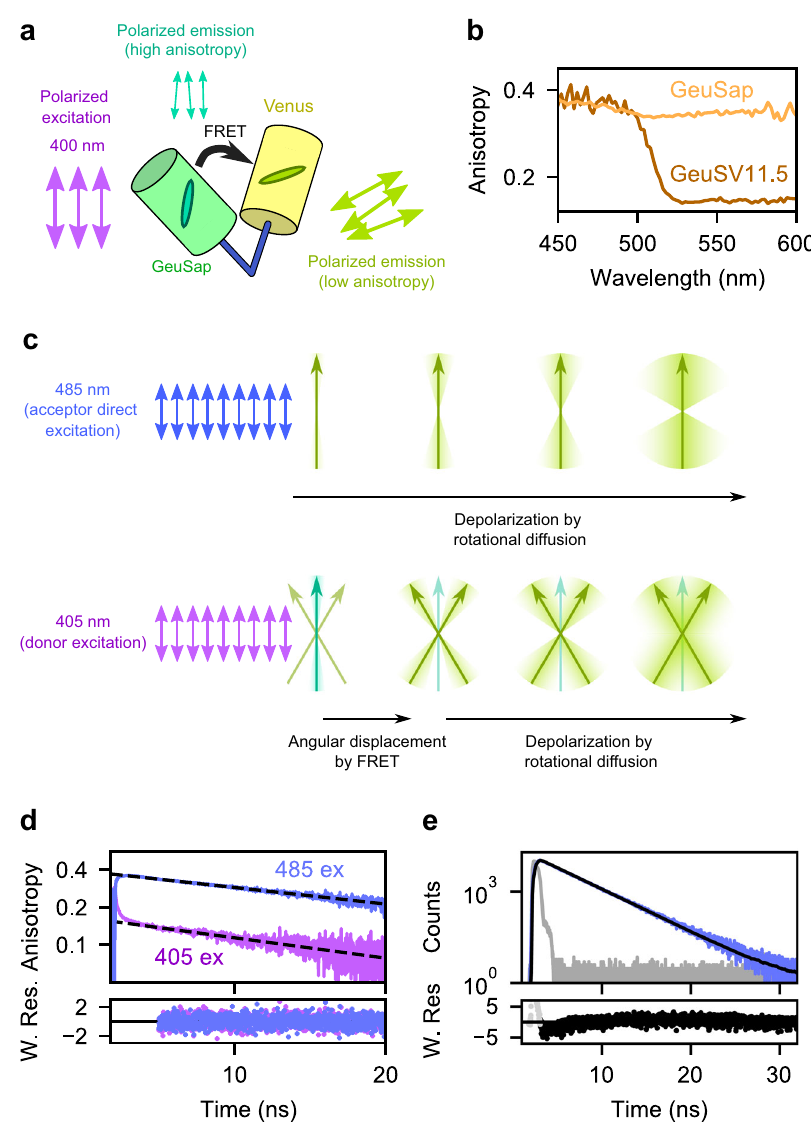
Fig. 3 GeuSV11.5 anisotropy. a Cartoon representation of GeuSV11.5 under polarized excitation. b Steady-state anisotropy spectra of GeuSap and GeuSV11.5. c Top: schematic drawing of direct acceptor excitation of GeuSV11.5 by linearly polarized light. The yellow-green arrow represents the emission dipole moment of the acceptor. After absorption of polarized light, the polarization of the emitted light is gradually lost as a result of rotational diffusion. Bottom: donor excitation of GeuSV11.5 by linearly polarized light. FRET is accompanied by angular displacement from donor (green arrow) to acceptor (yellow-green arrows) dipole moments. Anisotropy of the sensitized acceptor re fl ects initially the angular displacement, followed by gradual depolarization due to rotational diffusion. d Time-resolved anisotropy of GeuSV11.5 under donor (405 nm; purple) or direct acceptor (485 nm; blue) excitation. The decay after 5 ns was fi tted to a mono-exponential model, and yielded θ = 27 ns (sensitized acceptor) and θ = 34 ns (acceptor excited directly). e Fluorescence decay of GeuSV11.5 under 485 nm excitation (blue). The decay was fi tted to a mono-exponential model with reconvolution (black) and yielded τ = 3.1 ns with χ 2 = 1.29. W. Res.: weighted residuals. Source data are provided as a Source Data fi